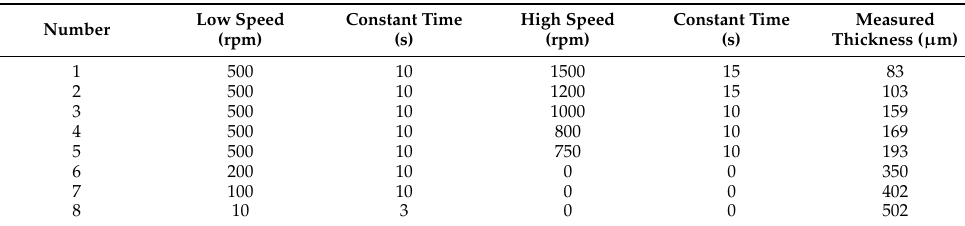
Table 1. Different rotational speeds corresponding to different PDMS thicknesses.